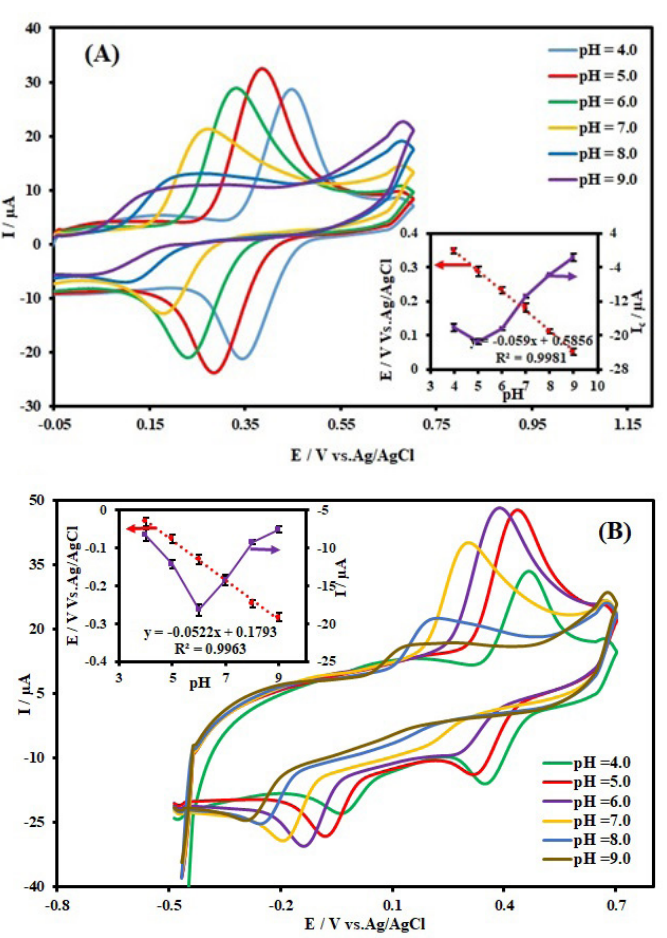
Fig. 8. Cyclic voltammograms of 500 µM DA (A), 500 µM EP (B) at GCE/RGO/TiO values (4.0 to 9.0) at a scan rate of 100 mV s −1 (Inset: Dependence of peak potential and peak current on